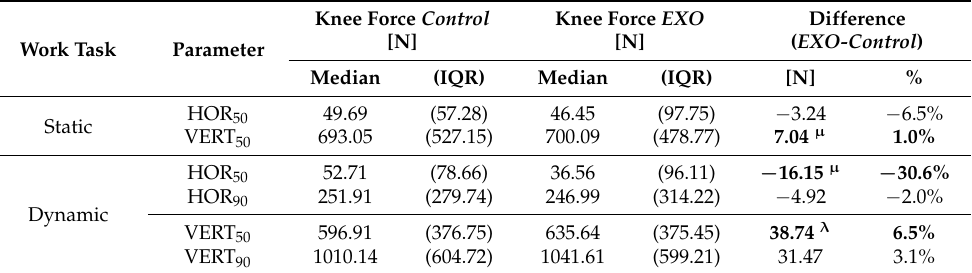
Table 1. Median knee force values and corresponding interquartile ranges (IQR), absolute and relative differences showing EXO compared to Control for static and dynamic work tasks (main